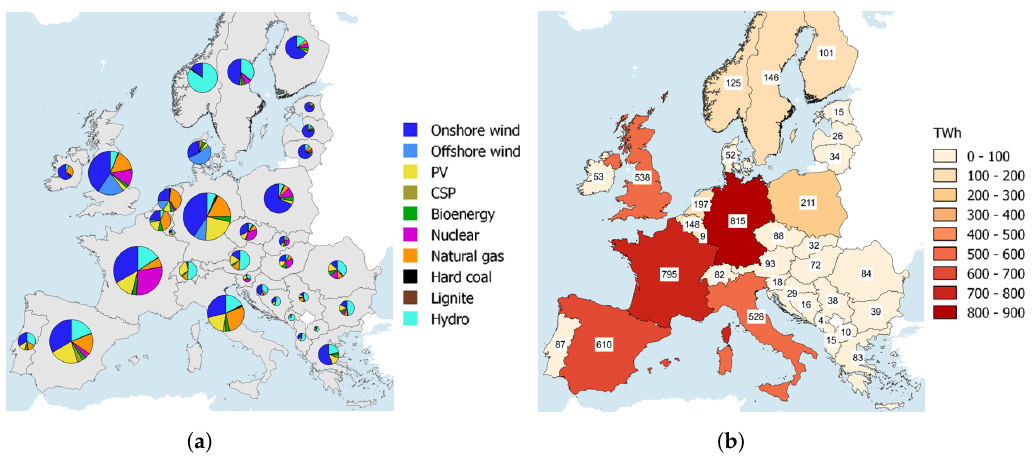
Figure 3. National capacity mix and electricity load of the investigated “large-scale RES” scenario for 2050 as defined by the e-Highway study [34]. Own illustration. ( a ) capacity mix; ( b ) electricity